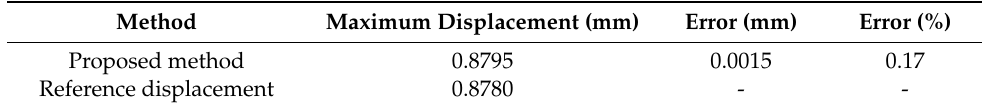
Table 5. Comparison of displacement measurements on the Jojungchun